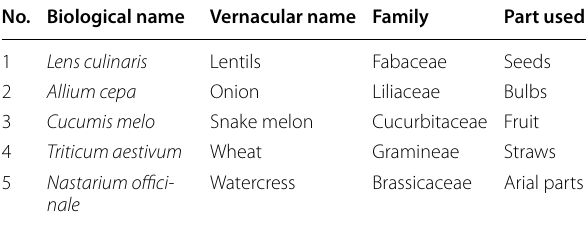
Table 1 Plants components of polyherbal formula (LACTN) No. Biological name Vernacular name Family